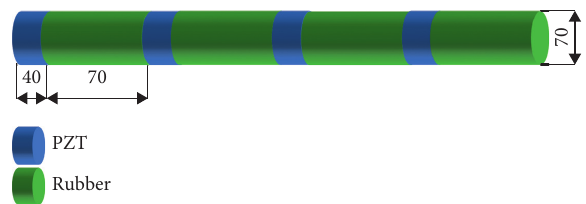
Figure 2: Schematic illustration of a